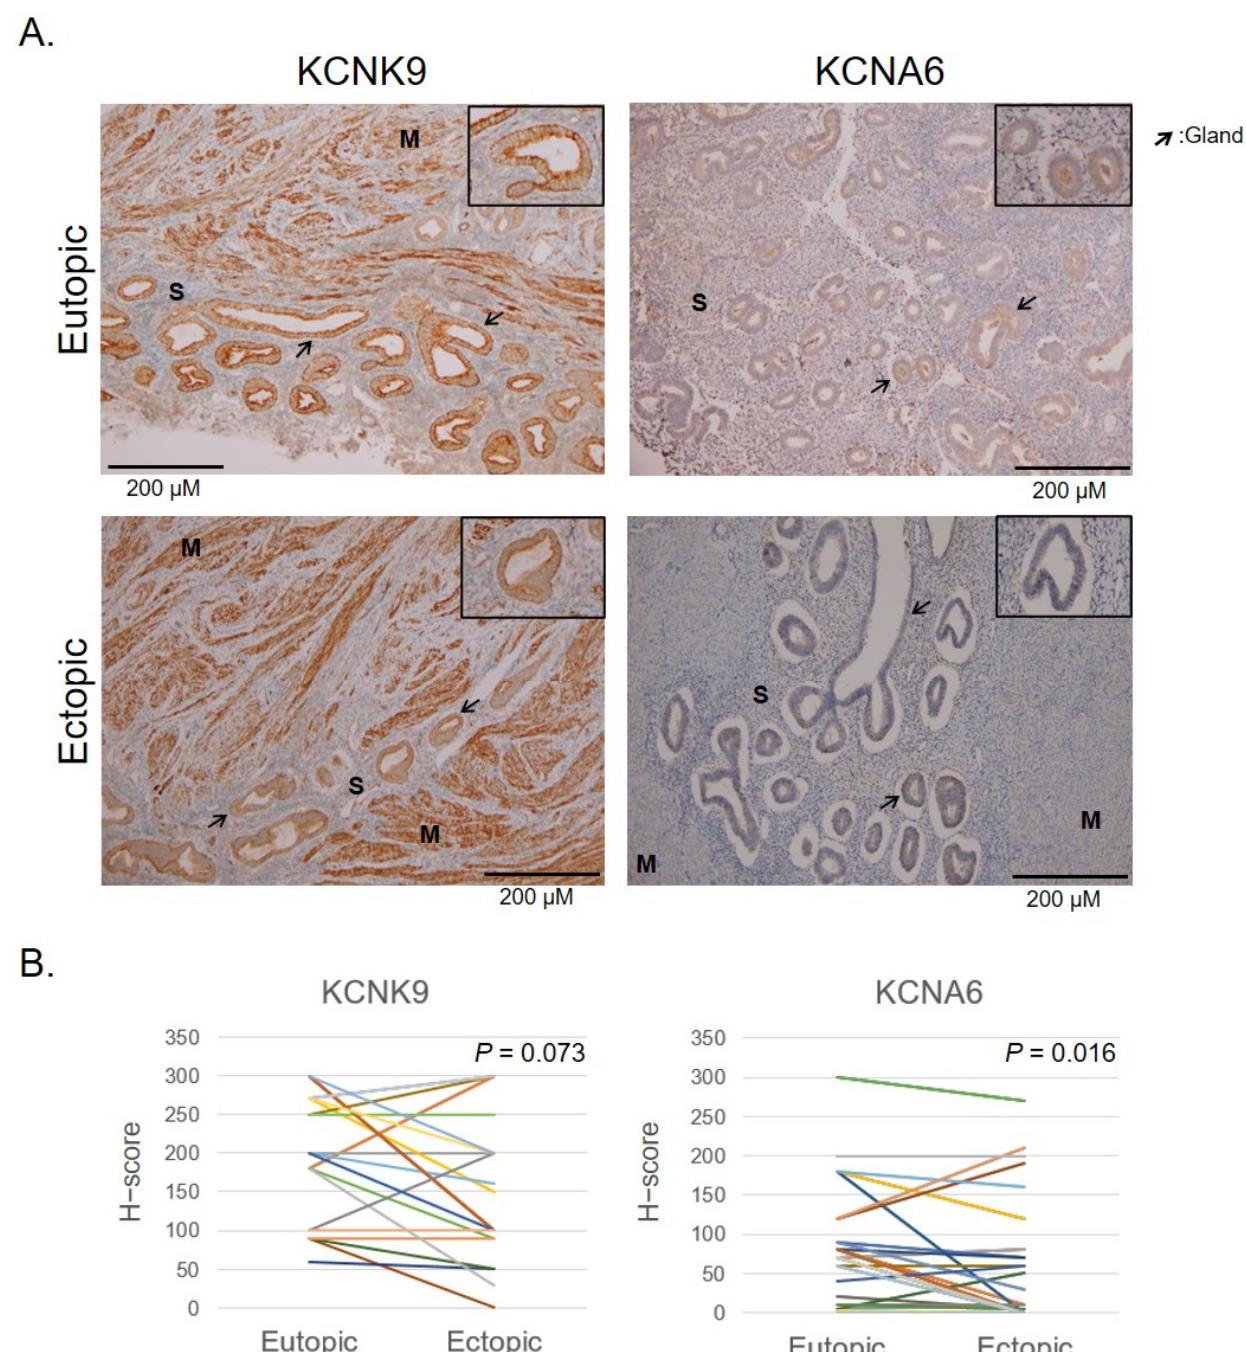
Figure 4. KCNK9 and KCNA6 expression in the ectopic endometrium in adenomyosis. ( A ) Repre- sentative IHC staining of KCNK9 and KCNA6 proteins. Endometrial glands (indicated by arrows). S, stroma; M, muscle. ( B ) Comparison of expression of KCNK9 and KCNA6 in ectopic and eutopic endometria. A significant difference was observed in the deceased KCNA6 in the ectopic endometrium ( p = 0.016, paired non-parametric Wilcoxon signed-rank test).